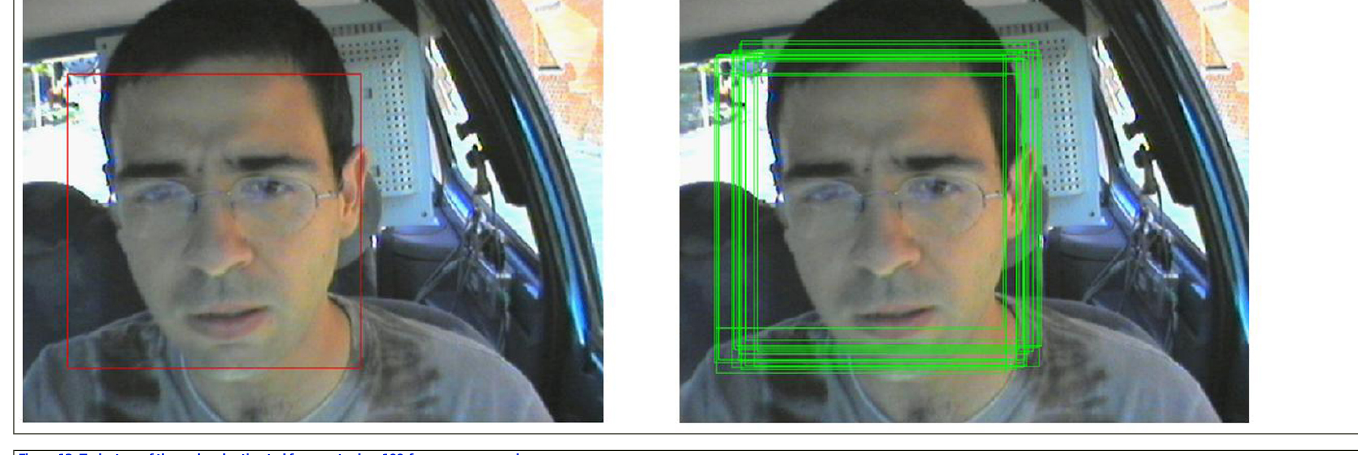
Figure 12 Trajectory of the real and estimated face-center in a 100-frame sequence using the proposed tracker.